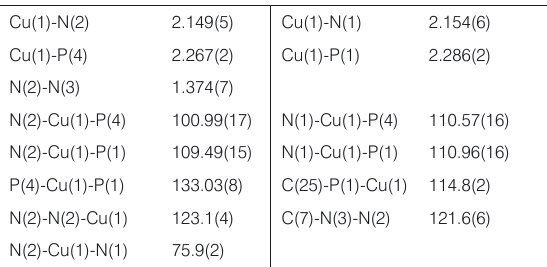
Table 2. Selected Bond Lengths (Å ) and Angles (deg) for the